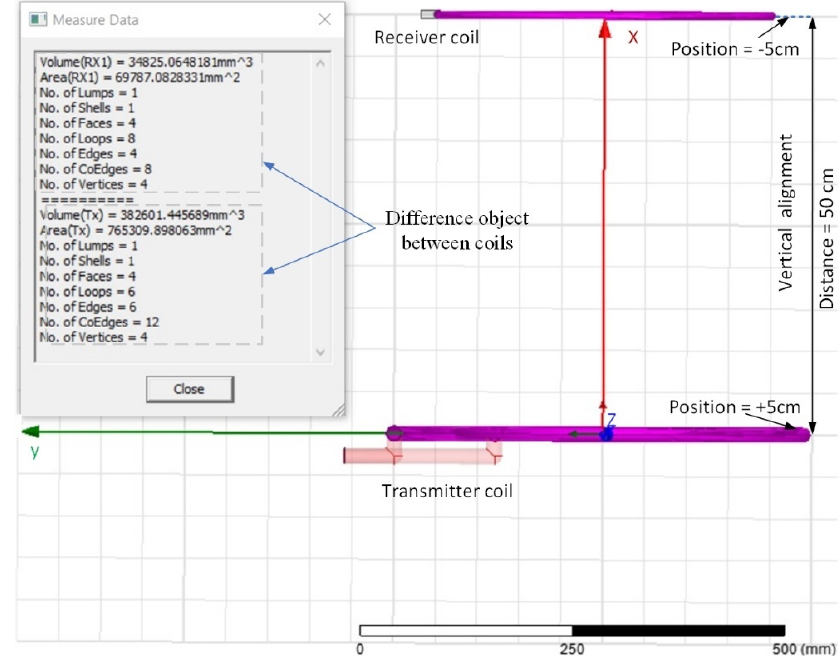
Figure 3. Alignment distance with x -axis at 2, 5, 10, 20, 30, 40, and 50 cm.